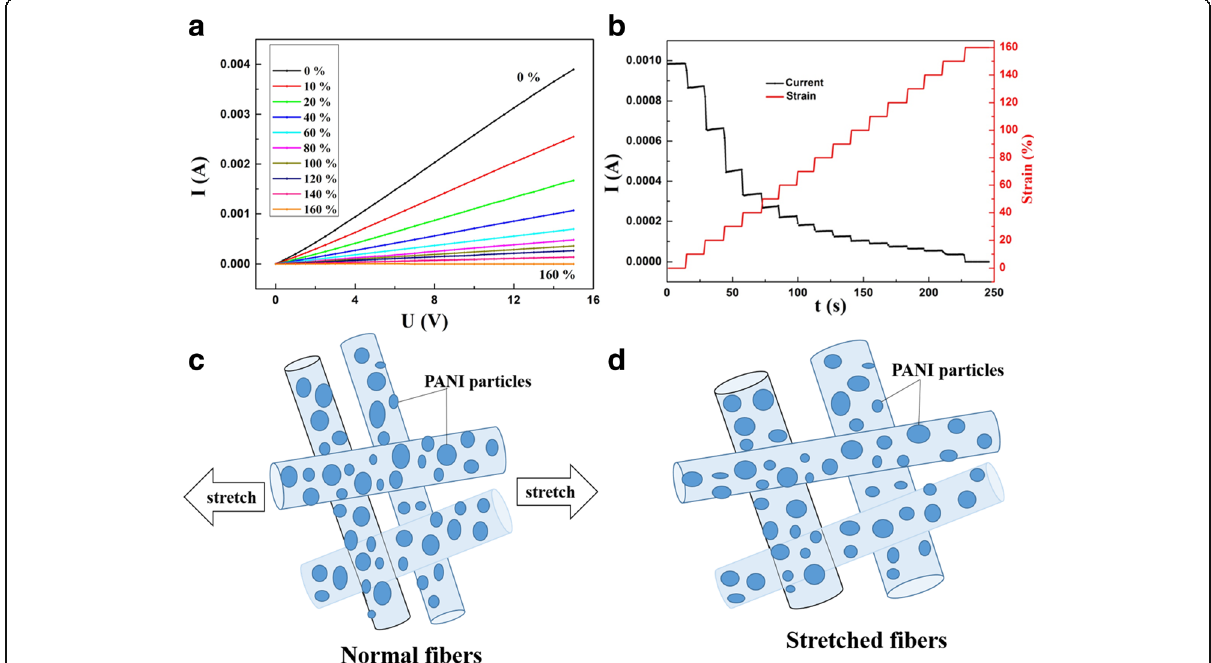
Fig. 4 Stretchability test and schematic diagram of the PANI/TPU membrane sensor. a I - V curves of PANI/TPU membrane under different strains. b Current responses of PANI/TPU membrane to different strains under a fixed bias of 5 V. c Fibers under no strain. d Fibers under